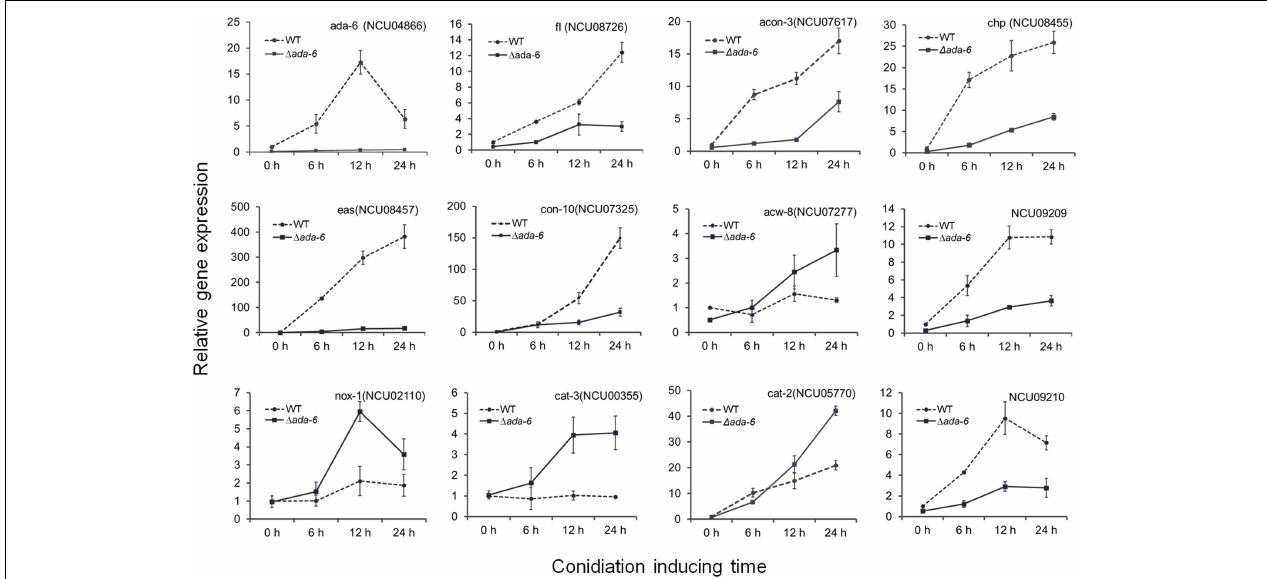
FIGURE 2 | The expressions of some DGEs, crucial for development and oxidative stress responses, were determined by time course experiment using RT-qPCR. Wild type (WT) and the ada-6 deletion mutant ( (cid:49) ada-6 ) were inoculated on Vogel’s plates and allowed to grow at 28 ◦ C in darkness for 24 h. The mycelia were then transferred into 150-ml flasks containing 75 ml of liquid Vogel’s medium (2% sucrose). Cultures were incubated at 28 ◦ C with constant agitation at 180 rpm for 18 h, and the mycelia were harvested by vacuum filtration and transferred onto the surface of agar plates (9 cm) to induce conidial development at 28 ◦ C under constant light. Cultures were sampled after induction for 6, 12, and 24 h. The total RNA was extracted and transcriptional levels of indicated genes were analyzed by RT-qPCR.